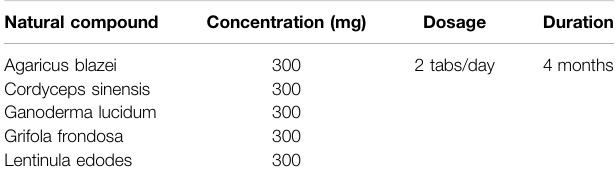
TABLE 5 | Support treatment administered as IM approach. Natural compound Concentration (mg)